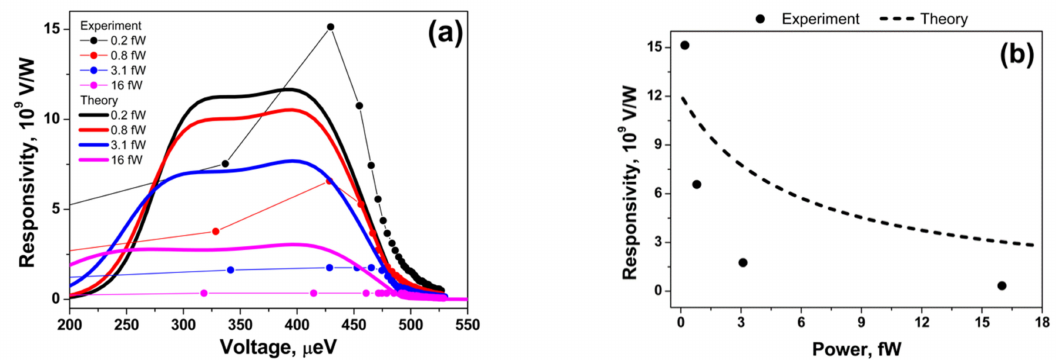
Figure 2. ( a ) The measured (solid circles) and theoretical (solid lines) responsivities of the CEB for various heating powers at a frequency of 35 Hz. ( b ) The dependence of the responsivity to the heating power. The circles represent the maximum responsivities, while the dashed line represents the prediction by